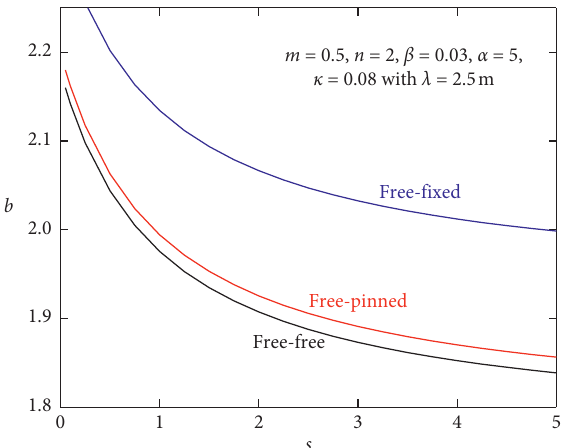
Figure 3: Dependence of the dimensionless buckling load b on the friction ratio s of the linear shaft friction, for three different boundary conditions: free-free, free-pinned, and free-fixed.